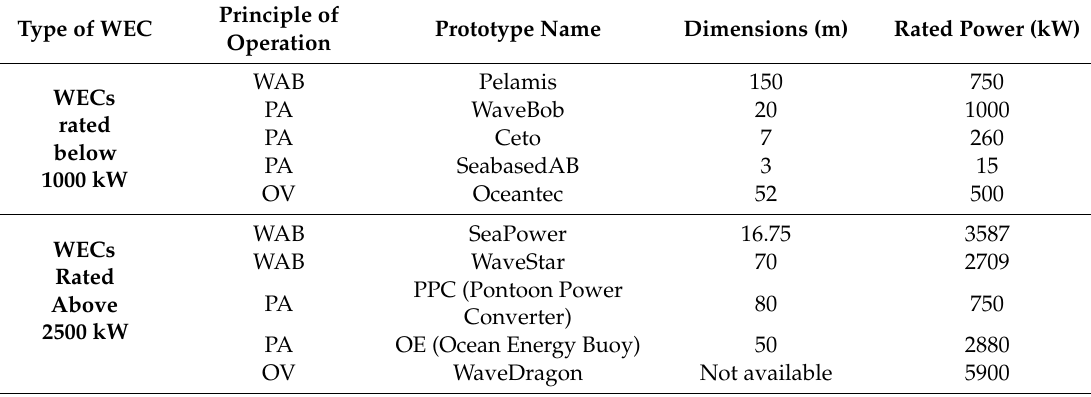
Table 3. Summary of the classification of WECs as a function of their corresponding rated power. Principle of Type of WEC